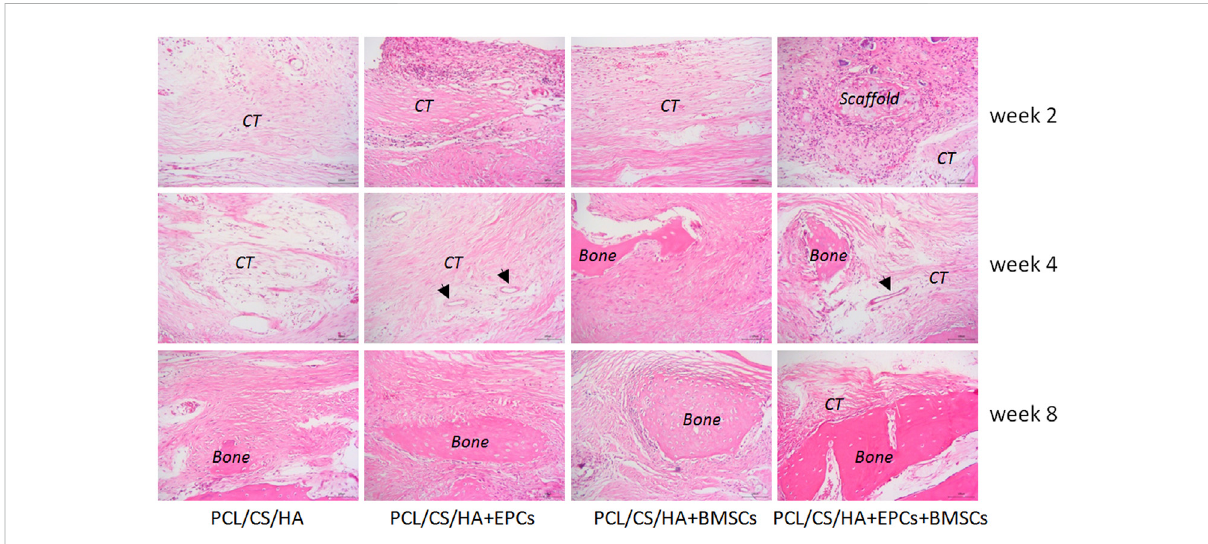
FIGURE 9 Histological structure of defected calvaria with composite scaffold repair at the post-surgery of the 2nd, 4th, and 8th week. New bone (bone), connective tissue (CT), and arrows indicate blood